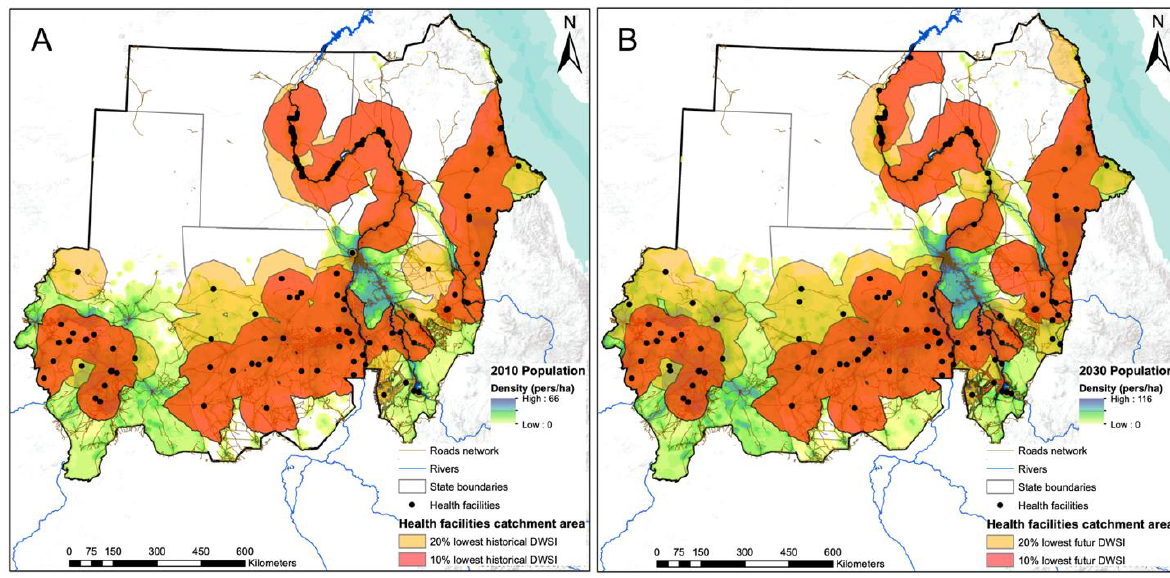
Figure 6. Historical ( A ) and future ( B ) catchment area of the 20% and 10% most water unsecure health facilities.